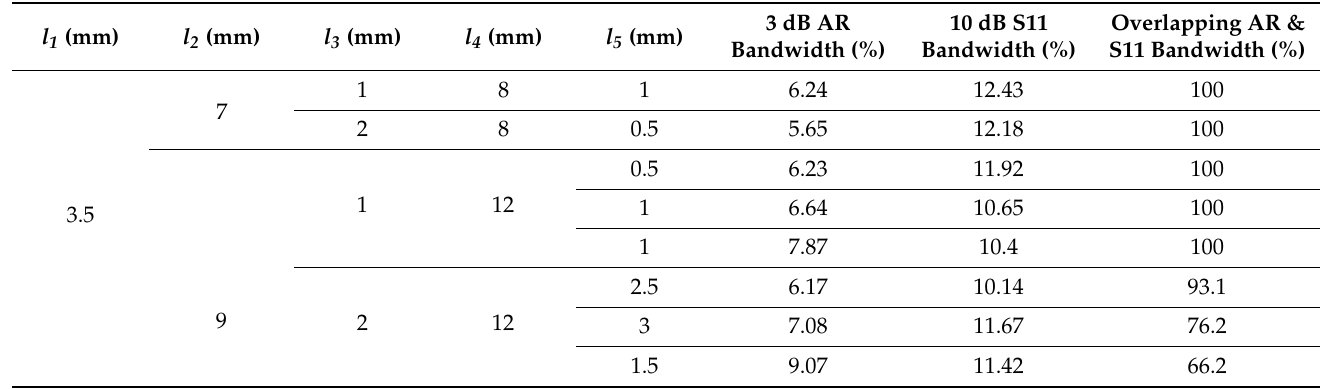
Table 1. AR and S 11 bandwidths for different feed dimensions of the proposed CP 5G RDRA.